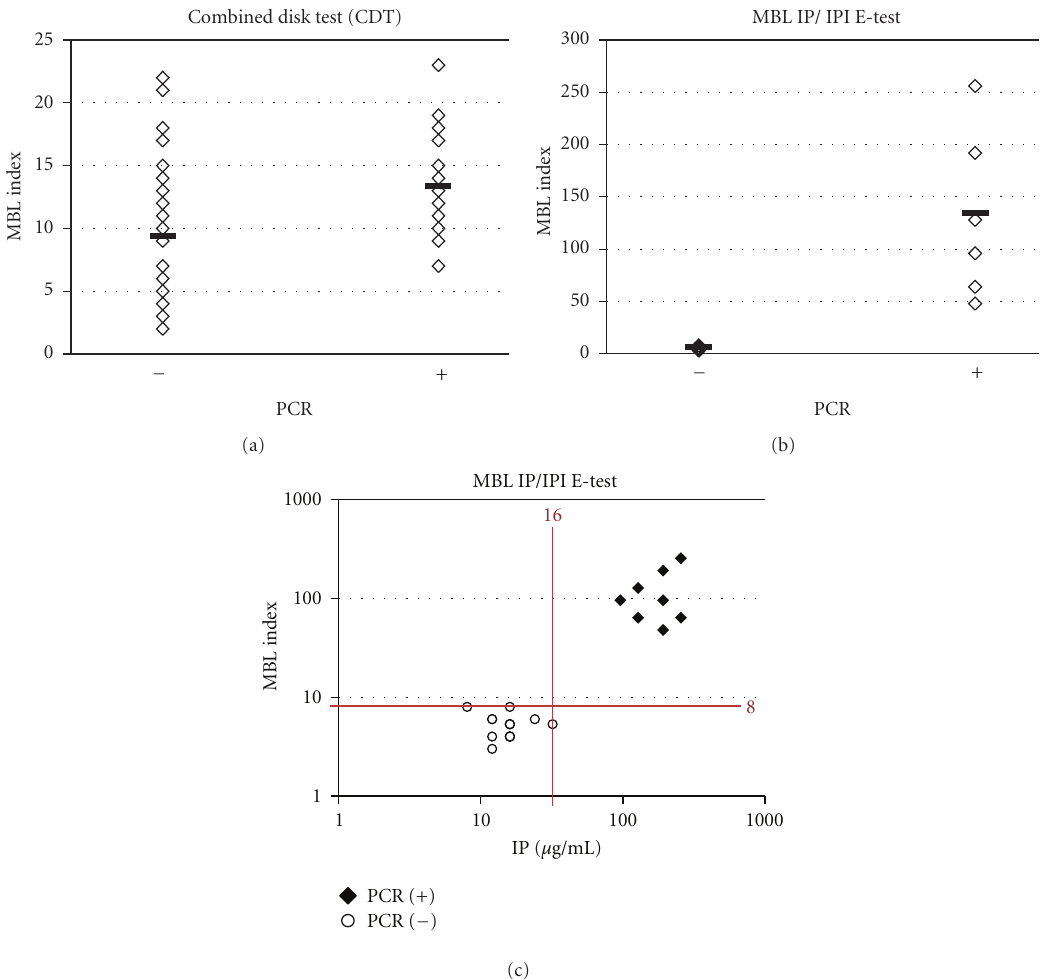
Figure 2: Correlation analysis of combined disk test (CDT), MBL IP/IPI E -test, and PCR detection of MBL genes. (a) MBL index by CDT was 9.5 and 13.4 for IRPA isolates that were negative and positive for MBL genes, respectively ( P < 0 . 001). (b) MBL index by IP/IPI E -test was 6.4 and 134.5 for IRPA isolates that were negative and positive for MBL genes, respectively ( P < 0 . 001). Statistical analysis was carried out using two-tailed Student’s t -test with P < 0 . 001 considered significant. (c) Strong correlation between IP MIC and MBL index with PCR detection of MBL genes. Together, IP > 16 μ g/mL and MBL index ≥ 8 were able to distinguish IRPA with MBL genes from those without. The proposed cuto ff values were determined from a receiver-operating characteristic (ROC) curve to obtain a 100% sensitivity and specificity for this data